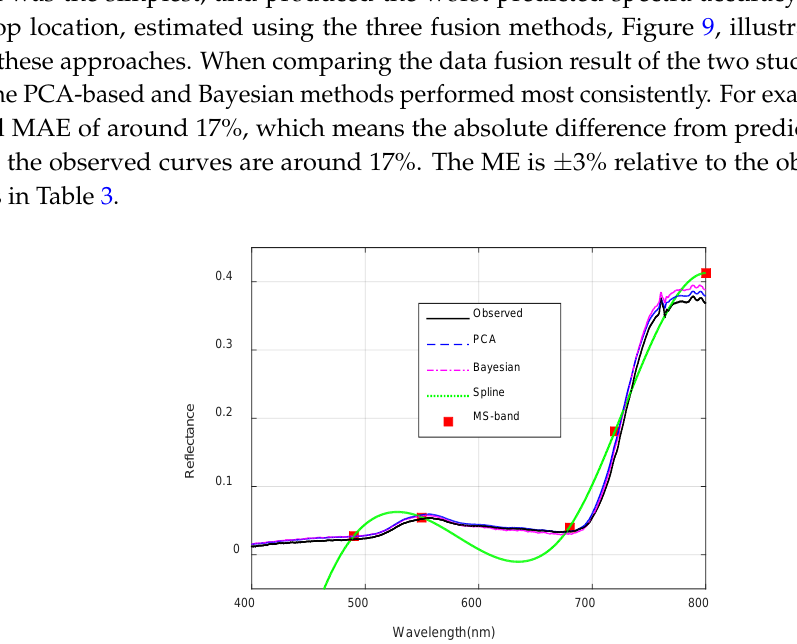
Figure 9. An example of the three types of data fusion compared with an observed spectrum over a crop sample at Site 1. The “PCA” is the “PCA_TSR” approach, “trimmed scores regression” defined in Section 3.2; the “Bayesian” is the “Bayesian_Gibbs” (Bayesian method with Gibbs sampling [27]) as defined in Section 3.2. “MS bands” are the spline interpolated reflectances derived directly from the multispectral (MS) camera data.